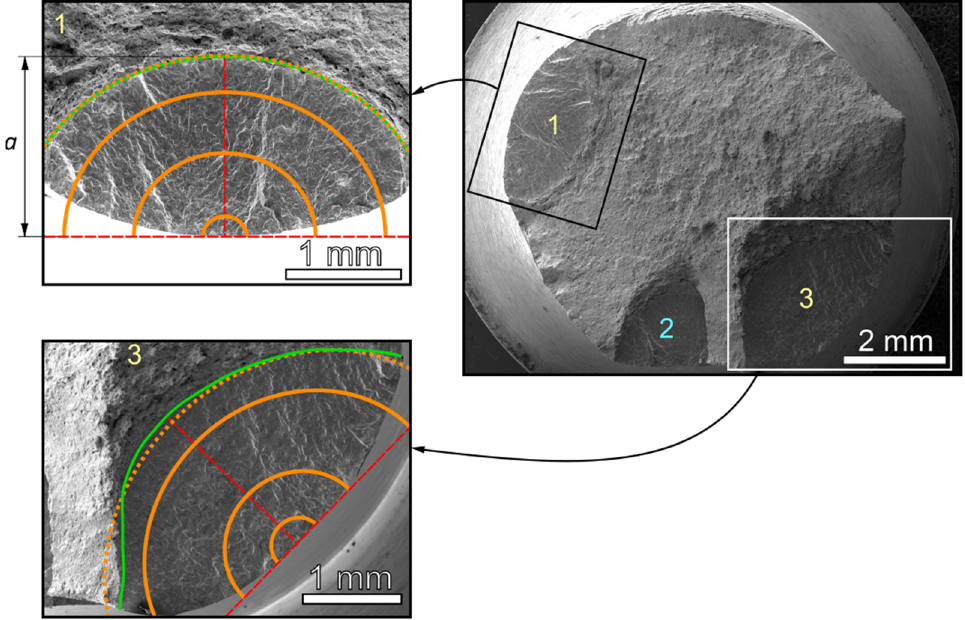
Figure 12. Fracture surface of Sanicro 25 cycled at ε a = 0.7%. Three developed cracks are denoted by numbers 1, 2 and 3. Cracks 1 and 3 were used for the comparison of numerically predicted crack front shapes with real crack front shapes, shown in the insets.